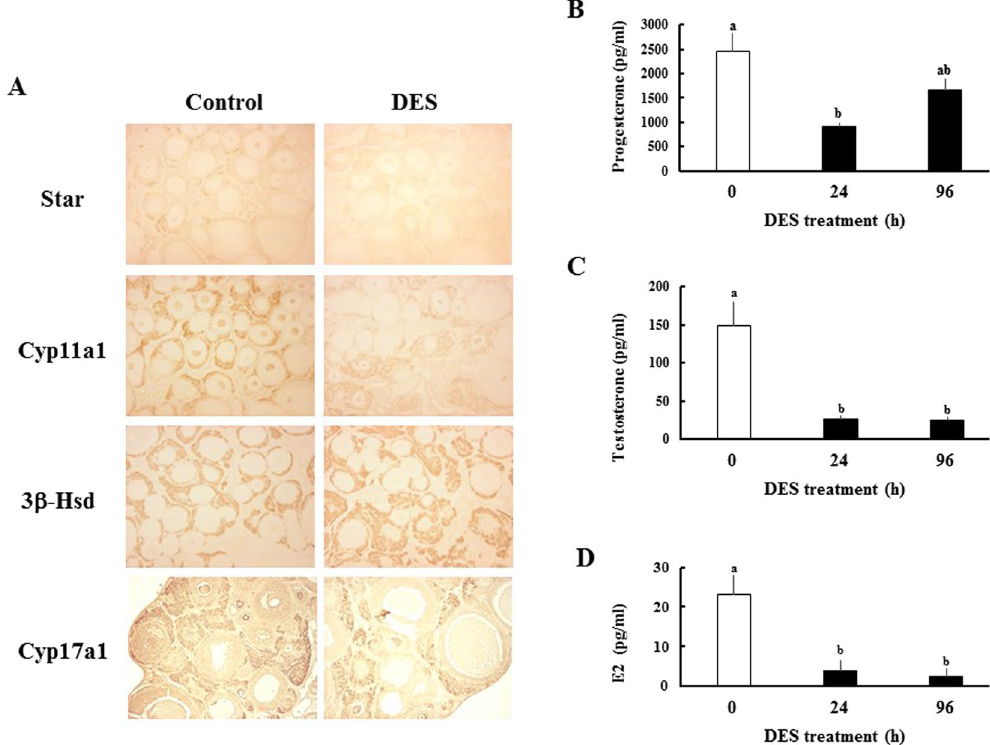
Figure 5. Effects of DES on the ovarian steroidogenesis-related proteins and the concentrations of serum steroid hormones. ( A ) Localization of Star, Cyp11a1, 3 β -Hsd and Cyp17a1 proteins in immature ovaries before or 6 h after DES injection. Positive staining both for each protein was observed in theca cells. ( B–D ) Serum progesterone, testosterone and E2 levels in immature female rats treated with DES for indicated times. Data represent the mean ± SEM of at least 5 independent samples. Values marked by different letters are significantly different ( P < 0.05).